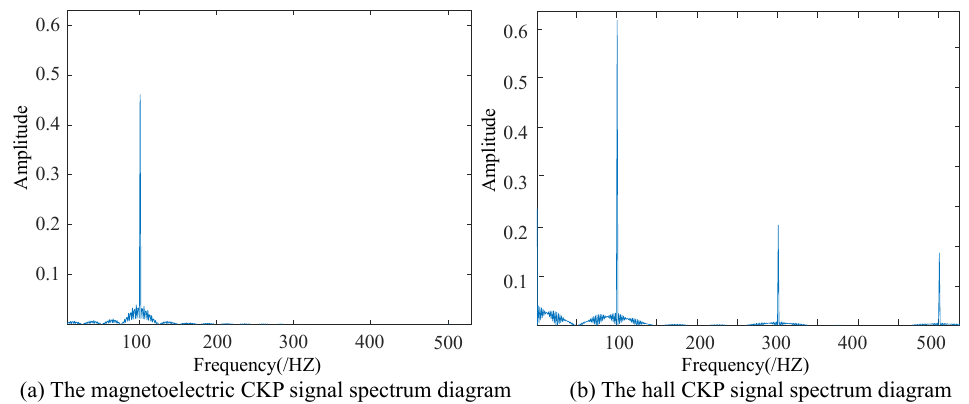
Figure 5. The CKP signal spectrum diagram. Magnetoelectric CKP signals have a maximum spectrum value of k at 100. The Hall CKP signal has a maximum spectrum value of k at